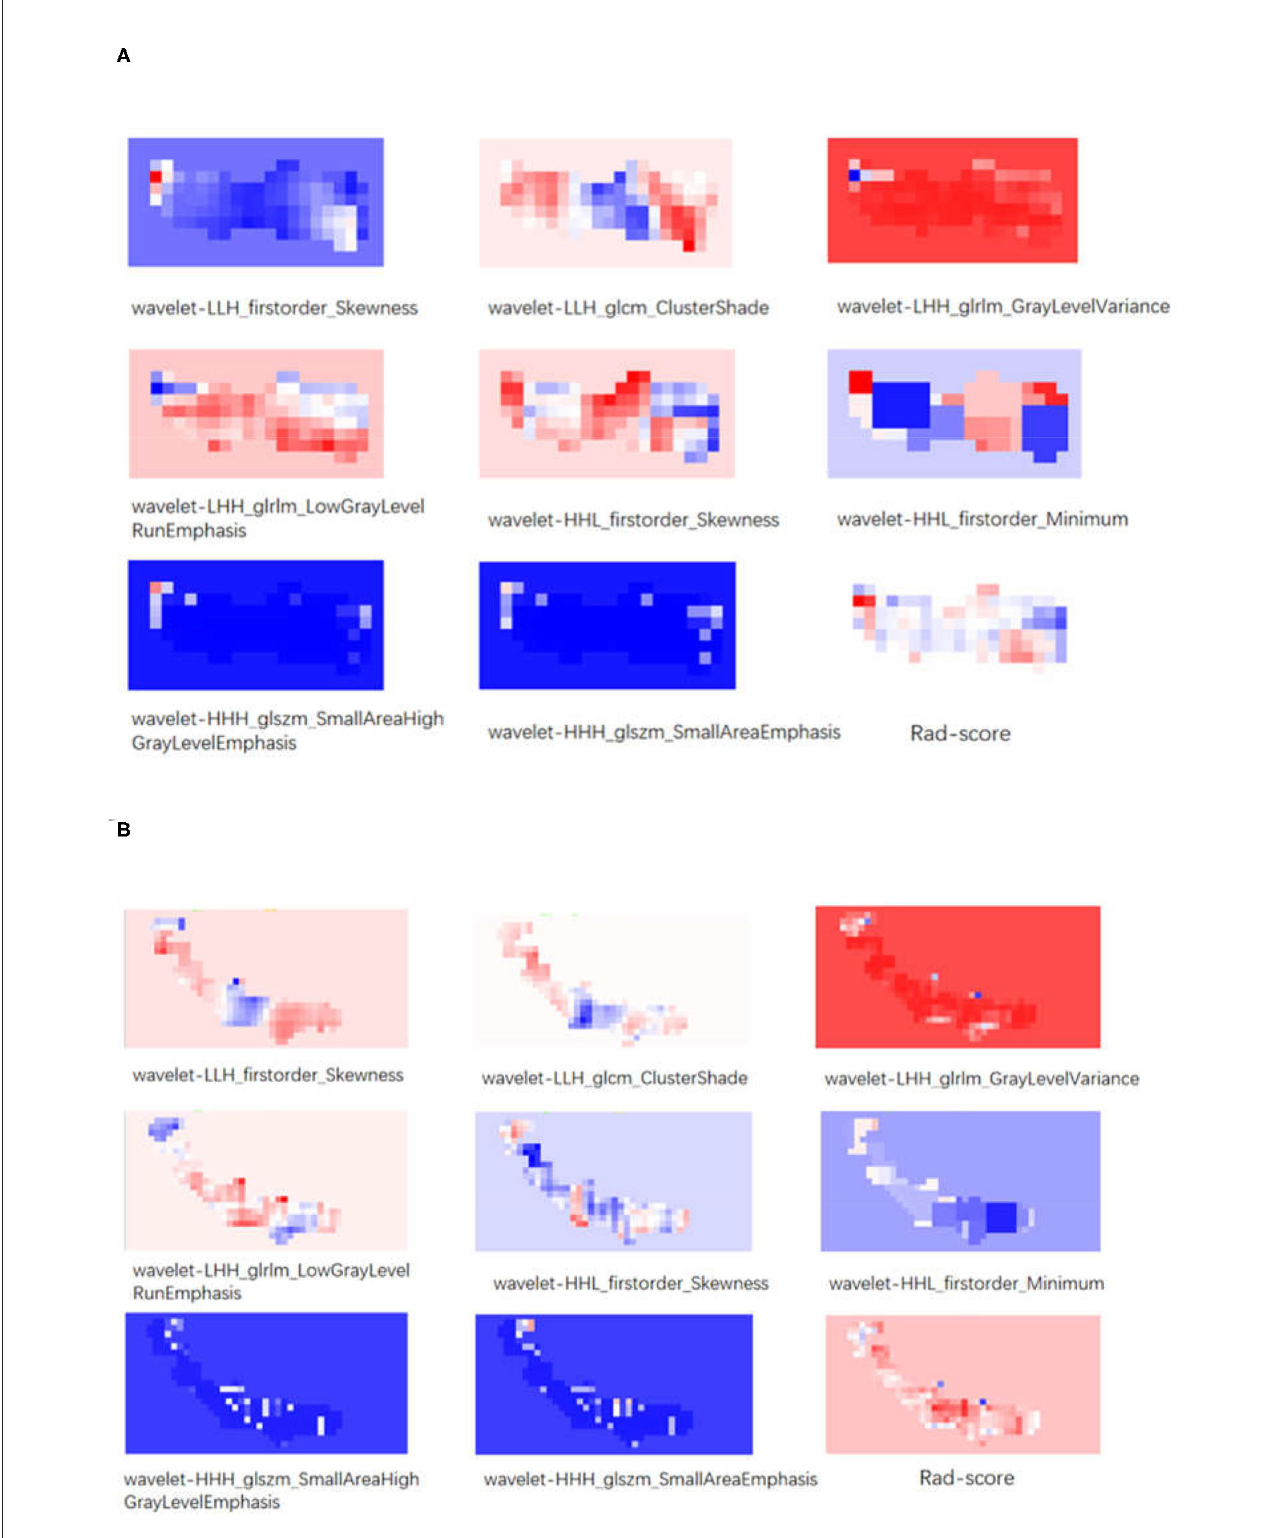
FIGURE3 (A) The visualization of texture features and Rad-score of a patient with a good prognosis. (B) The visualization of texture features and Rad-score of a patient with a bad